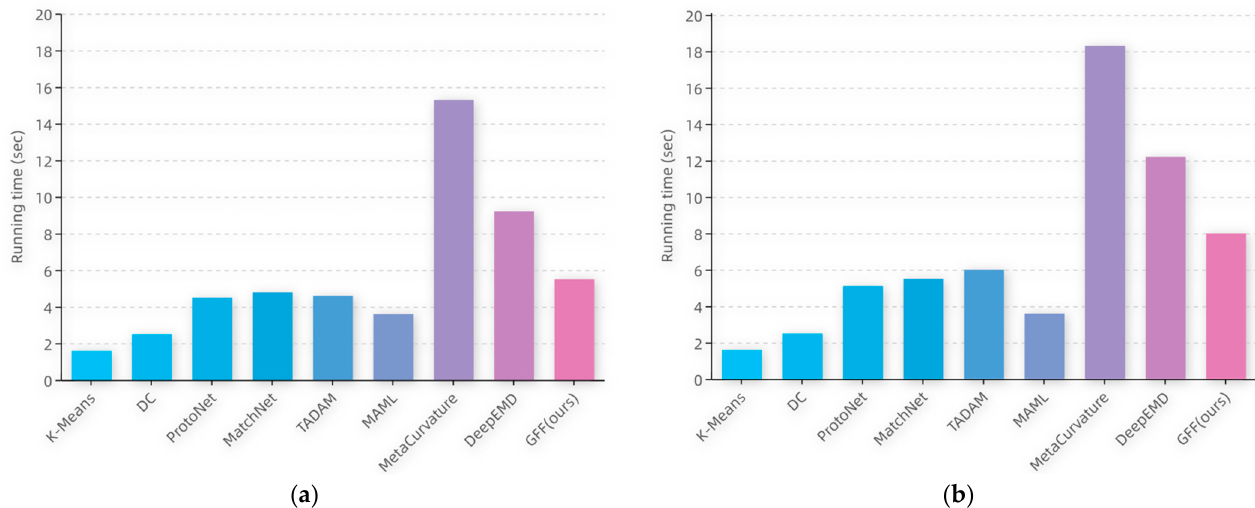
Figure 8. The running time of a single sample test phase for different methods in ( a ) the 5-way 1- shot case and ( b ) the 5-way 5-shot case. case and ( b ) the 5-way 5-shot